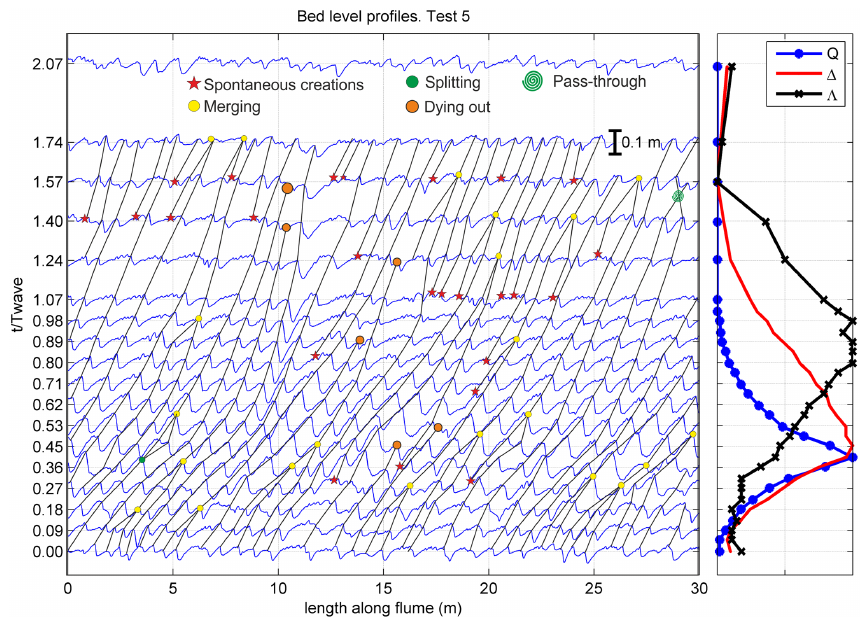
Figure 6. Bed profiles from flume experiment T43 (test 5) of Wijbenga and Van Nes (1986a). Right panel shows the discharge (Q), dune height ( 1 ) and length ( 3 ) in time, normalized between 0 and 1 (vertical axis). The crests of individual dunes are connected with lines and dune interactions are classified as creations, merging, splitting, dying-out or